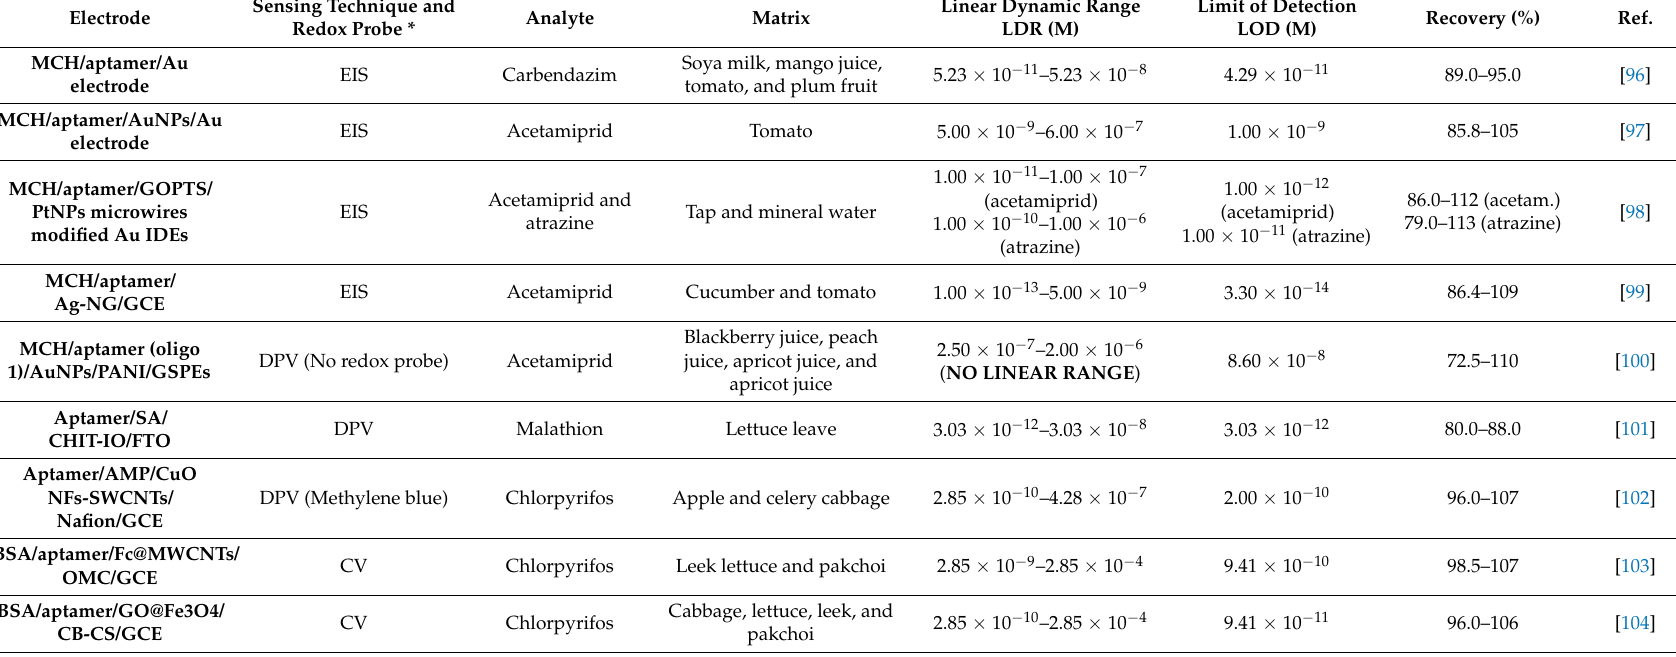
Table 3. Electrochemical aptasensors for pesticides detection in food: main features and